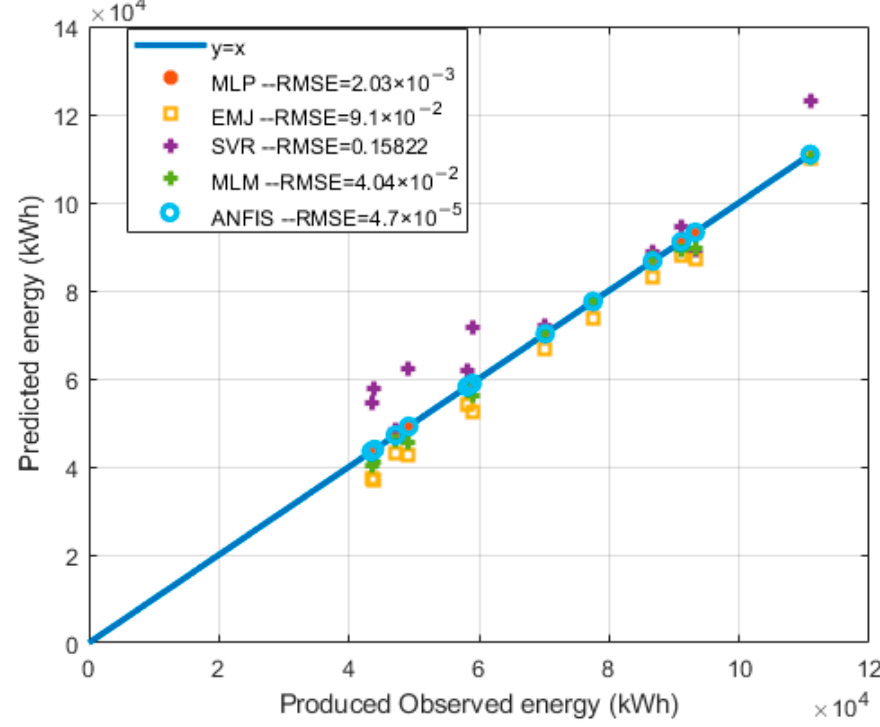
Figure 17. Lom é : correlation between observed and estimated wind energy Figure 17. Lomé: correlation between observed and estimated wind energy output.